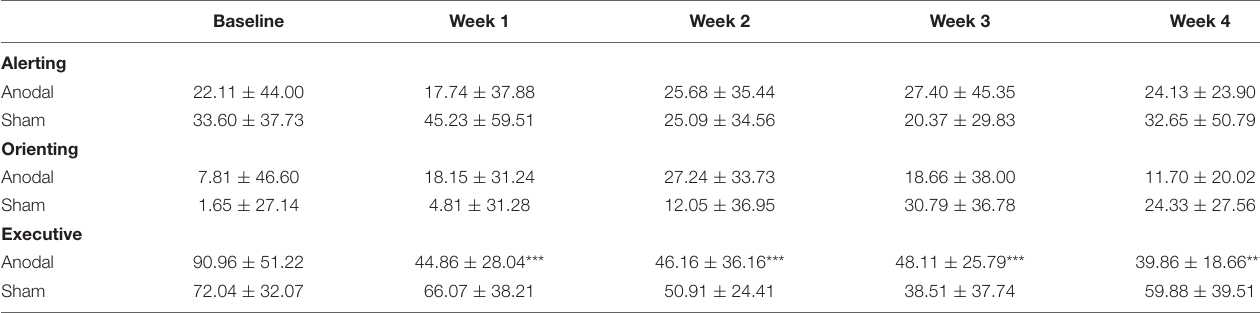
TABLE 3 | Mean reaction time on three conditions of ANT from baseline to week 4 in the anodal and sham groups.